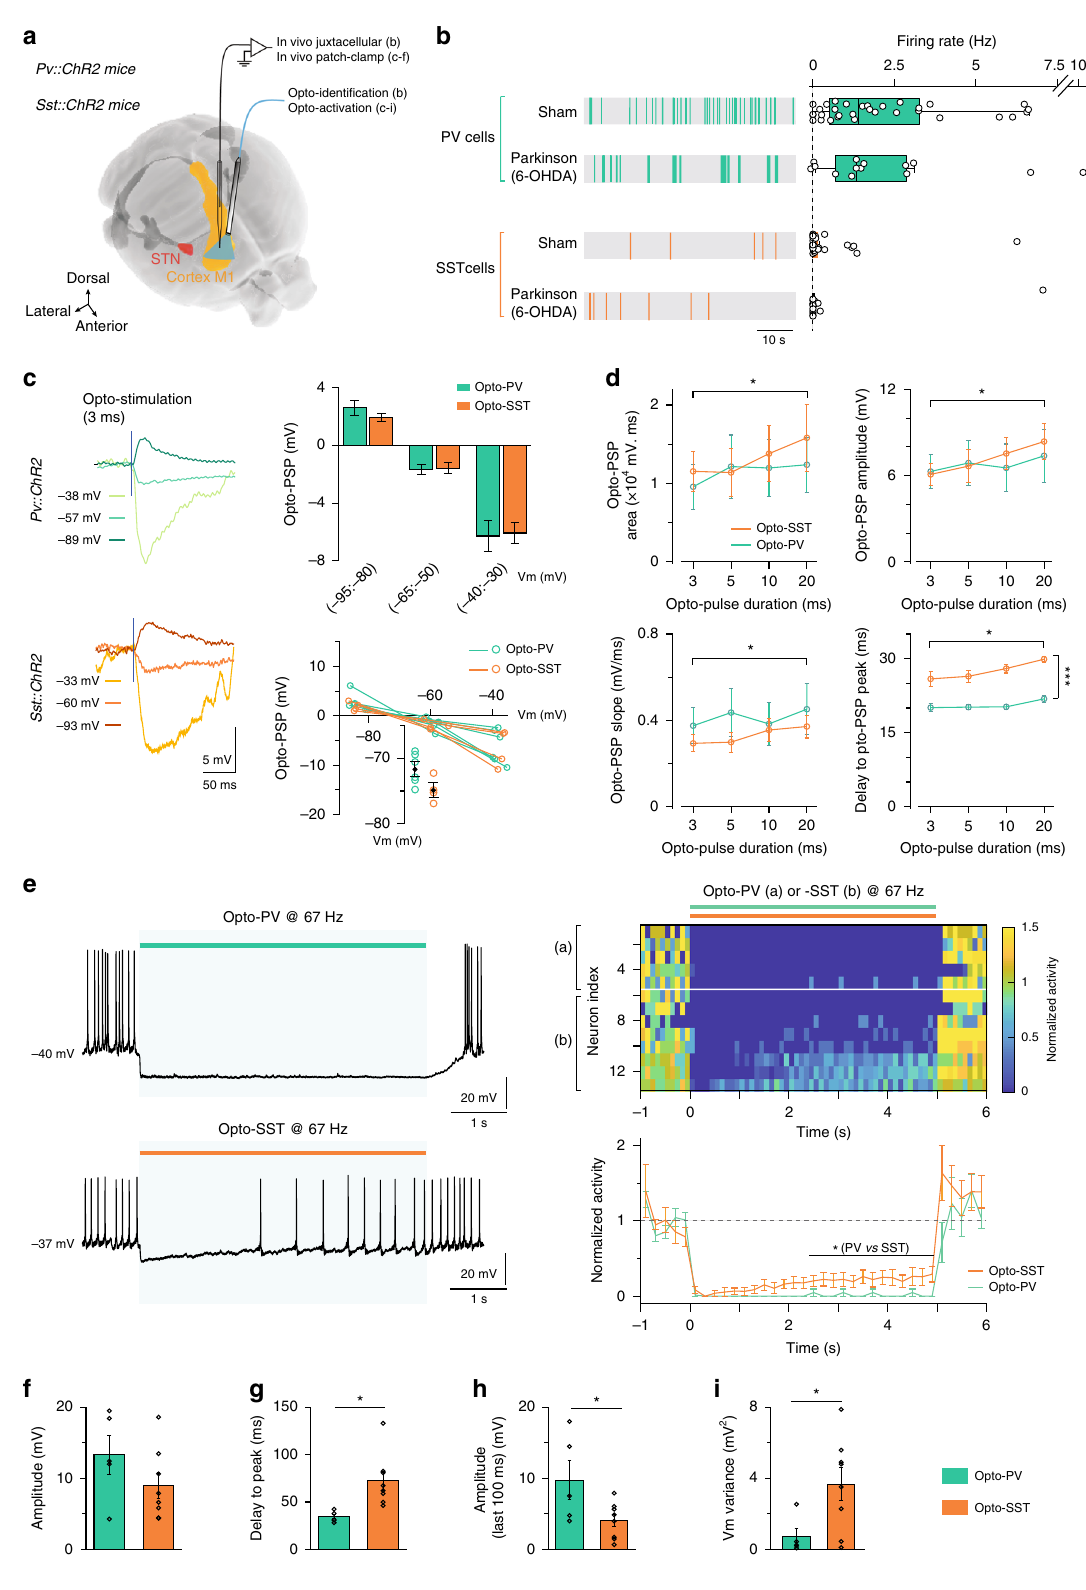
classi fi er, multinomial logistic regression, linear discriminant analysis and support vector machines; Supplementary Table 3) to discriminate network responses to 20 different stimuli (Fig. 7a, d). Binned spiking patterns from all pyramidal cells were densi fi ed using a random matrix to mimic highly convergent cortico-